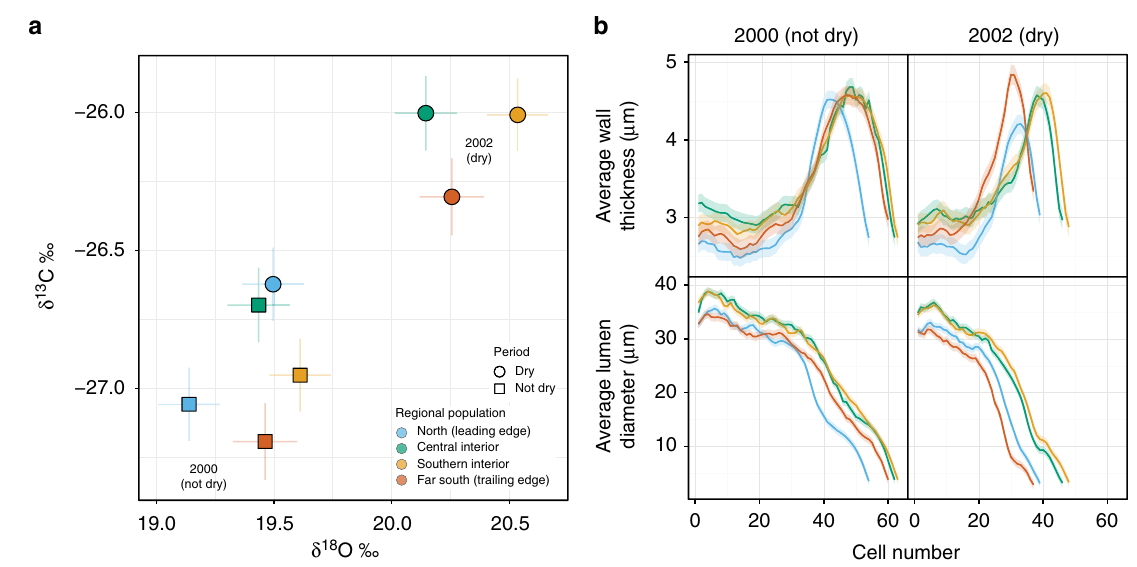
Fig. 3 Plasticity among populations of lodgepole pine. a Response of stable isotopes in two years of different moisture levels. b Average tracheid wall thickness and lumen diameter as a function of cell number under different moisture conditions in the year 2000 (not dry) and 2002 (dry). Each of the regional populations are colored according to Fig. 1. Based on n = 1170 (4 populations × 5 provenances × 1 tree × 3 sites × 2 blocks× 10 years, minus 3 trees). Error bars ( a ) and ribbons ( b ) are standard errors of the